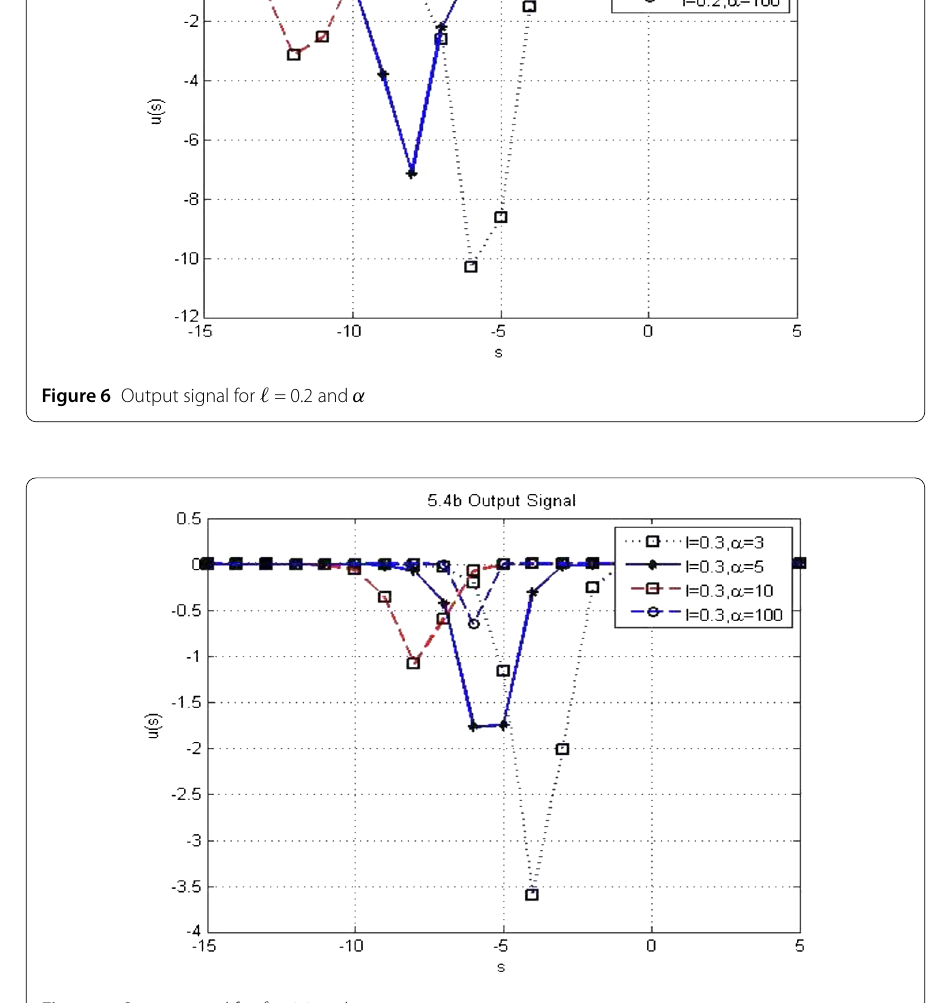
Figure 7 Output signal for (cid:5) = 0.3 and